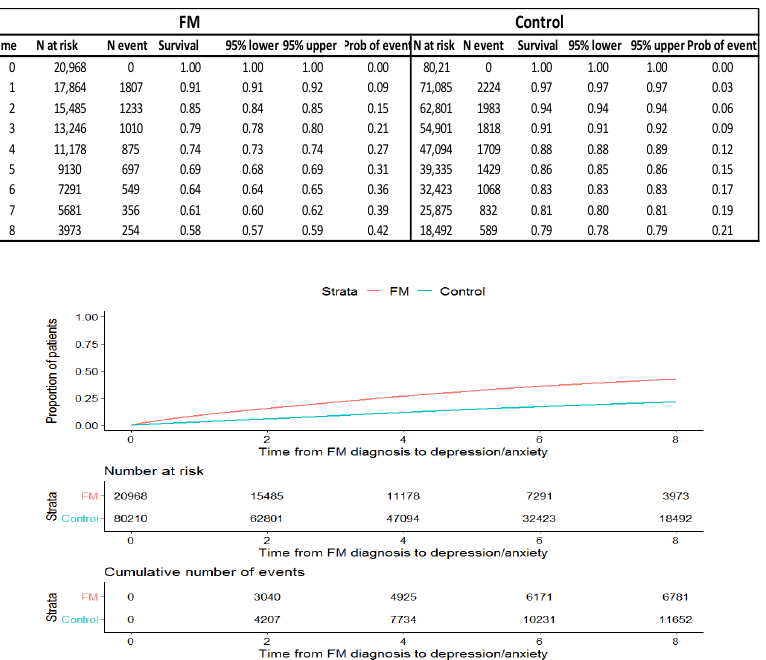
(Figure 1) Kaplan – Meier survival curve for anxiety and/or depression from 2010 to 2017, separating patients according to general population, FM prevalent population and FM incidence population.